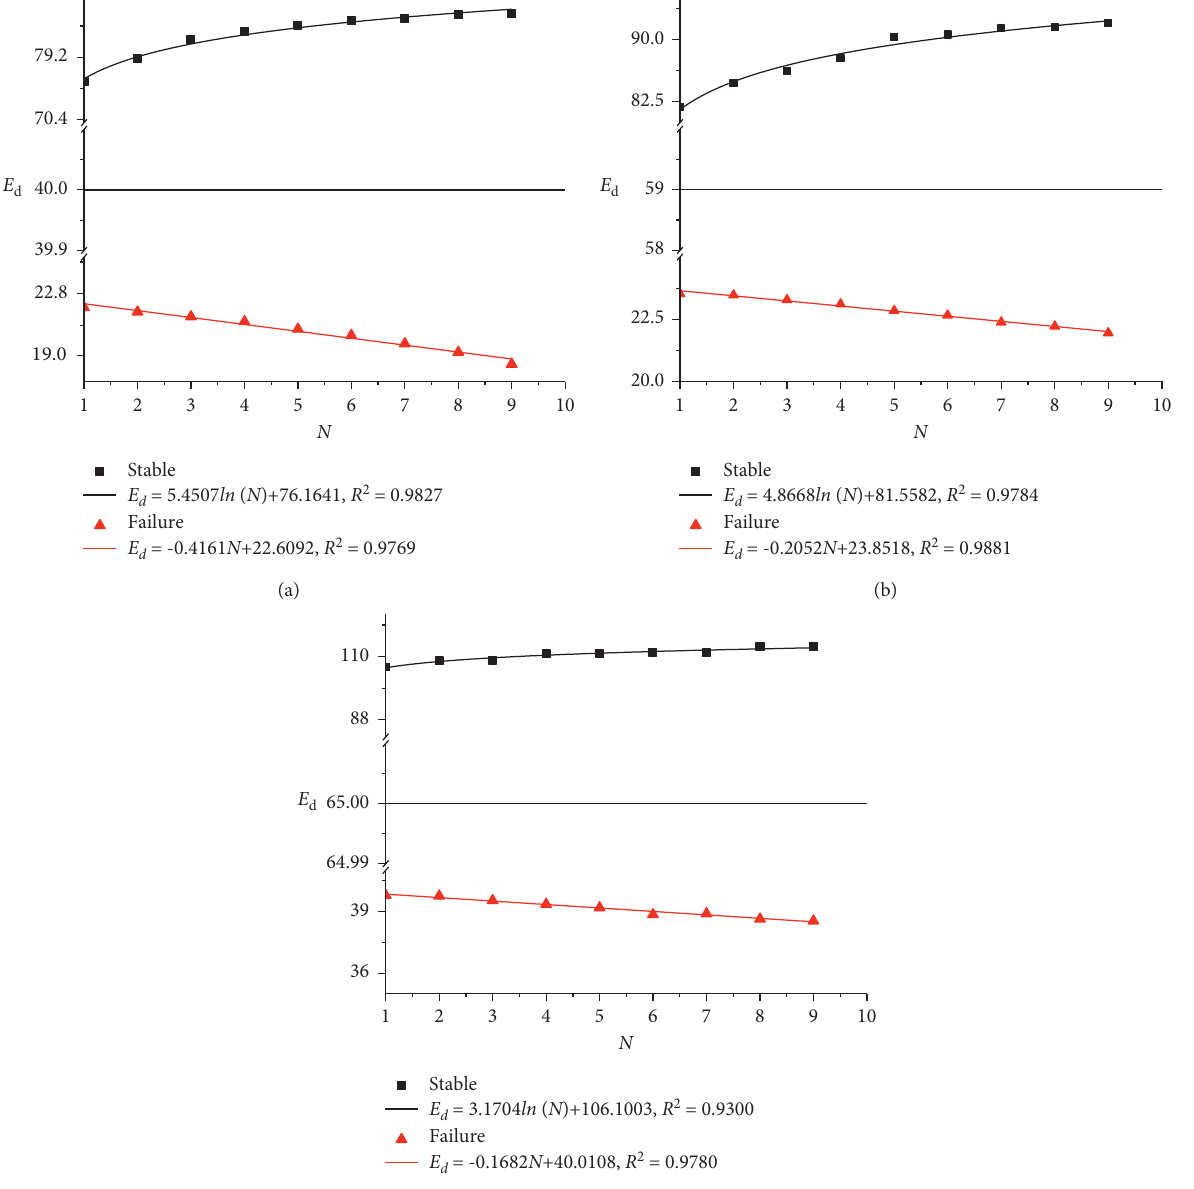
Figure 13: Dynamic elastic modulus versus cycle number curves in stable and failure zones. (a) 0.5Hz. (b) 1Hz. (c)